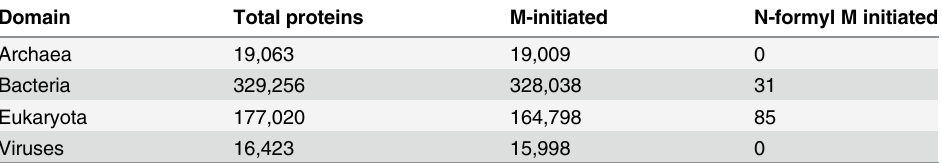
Table 4. Distribution of methionine and N-formyl methionine (M) initiated proteins in SwissProt